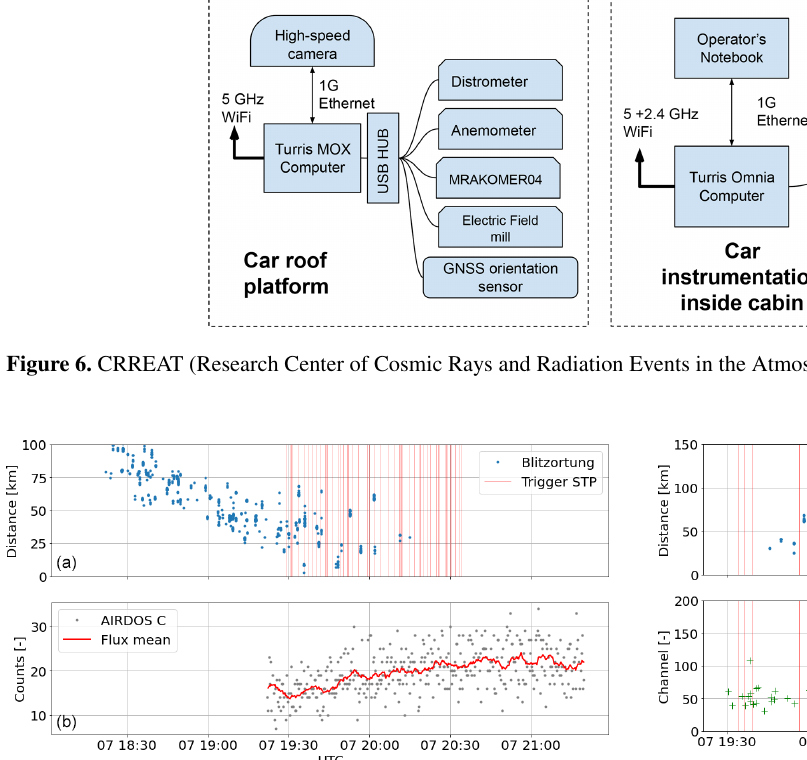
Figure 7. Measurements of ionizing radiation using a car compared with lightning registered by antennas. The beginning of the mea- surements using the AIRDOS-C and STP antennas corresponded to switching on the devices after parking the car at a measurement lo- cation at 19:15UTC. The end of the measurements at 21:25UTC corresponded to switching off the devices and leaving the measure- ment location.